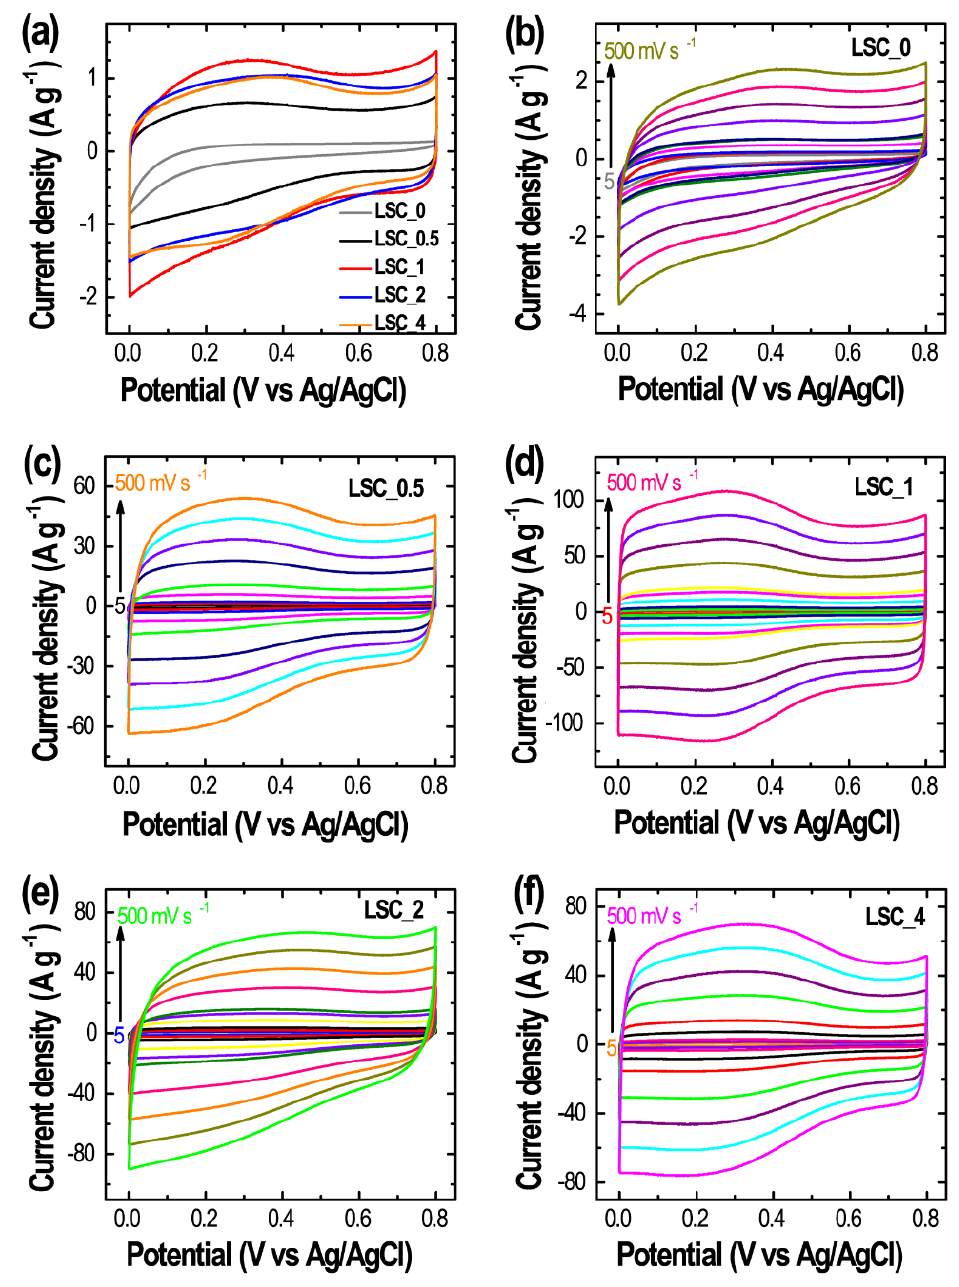
Figure 5. ( a ) Cyclic voltammetry (CV) curves of all the samples at a constant scan rate of 5 mV s −1 , and the corresponding CV curves at different scan rates from 5 to 500 mV s −1 . ( b ) LSC_0 , ( c ) LSC_0.5 , ( d ) LSC_1 , ( e ) LSC_2 , and ( f ) LSC_4 .